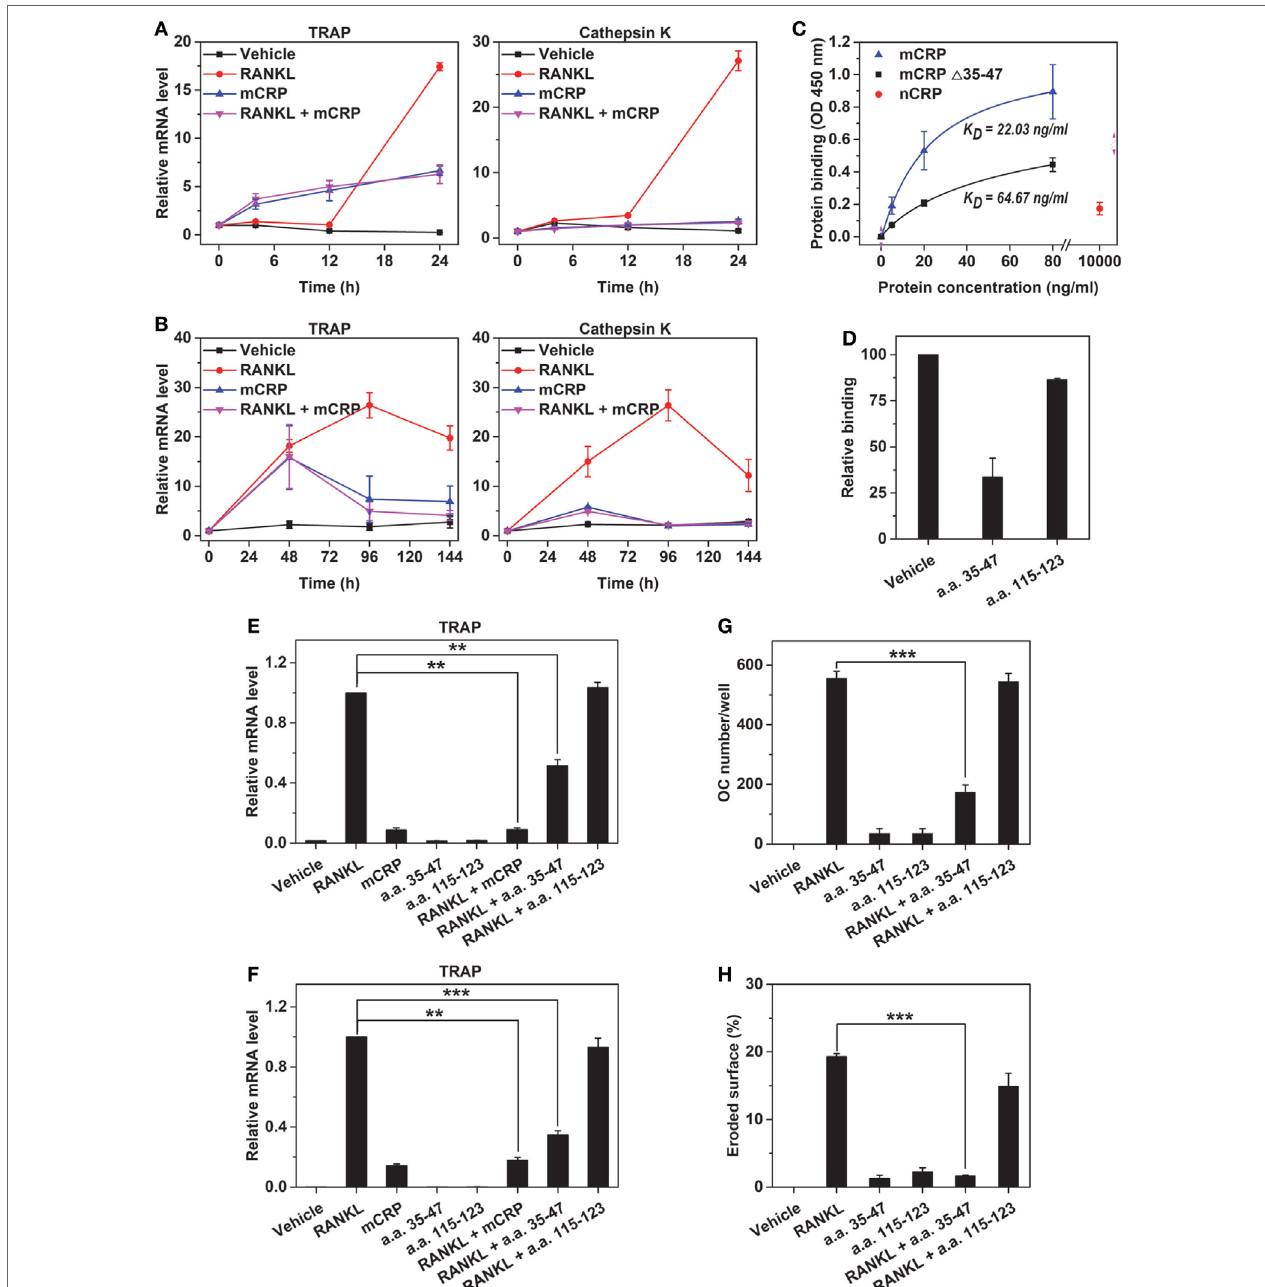
FigUre 6 | mCRP binds receptor activator of NF- κ B ligand (RANKL) via cholesterol-binding sequence. Bone marrow-derived macrophages (BMDMs) (a) or peripheral blood mononuclear cells (B) were treated with RANKL, mCRP, or their combination for the indicated times. In both cell types, the effects of RANKL were abrogated by cotreatment of mCRP at all time points tested. (c) mCRP, mCRP Δ 35–47, or native C-reactive protein (nCRP) at the indicated concentrations were added to RANKL immobilized on microtiter wells. mCRP avidly bound immobilized RANKL, but this binding was impaired by deleting a.a. 35–47. Weak binding of nCRP was only detected at very high concentration. a.a. 35–47 peptide (20 µg/ml) nearly abrogated the binding of mCRP to RANKL (D) , halved RANKL-induced TRAP expression in Raw (e) and BMDM (F) , and greatly suppressed RANKL-induced differentiation of osteoclasts (g) and their bone resorption activities (h) . By contrast, another CRP peptide, i.e., a.a. 115–123 (20 µg/ml), showed no effect in these